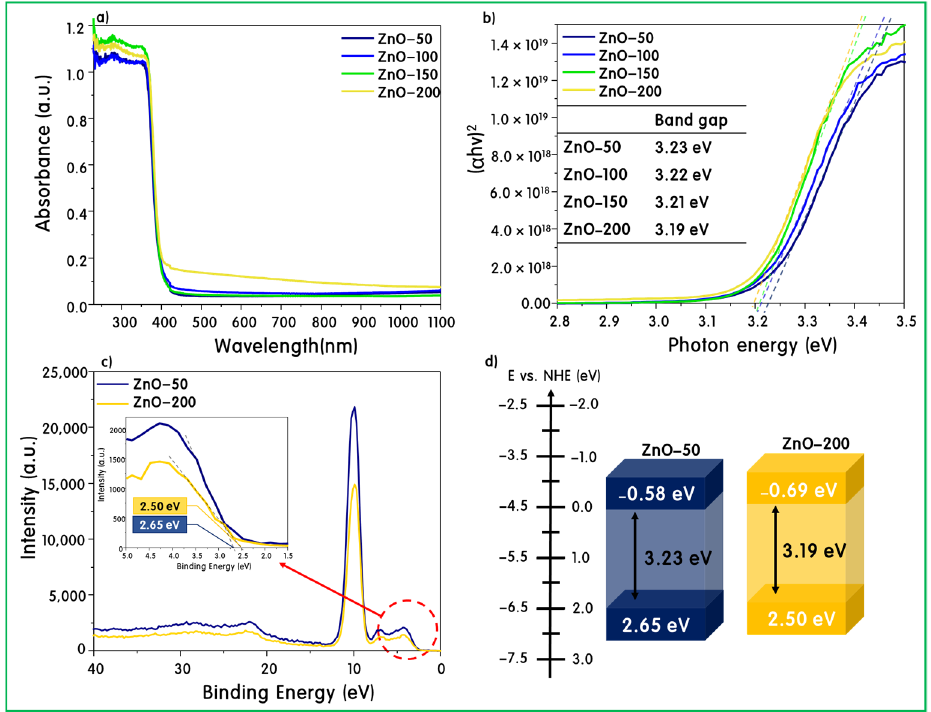
Figure 4. ( a ) DRS-UV-Visible absorption spectra, ( b ) Tauc’s plot curves, ( c )XPS valence band, and ( d ) energy diagrams for the bandgap positions of the